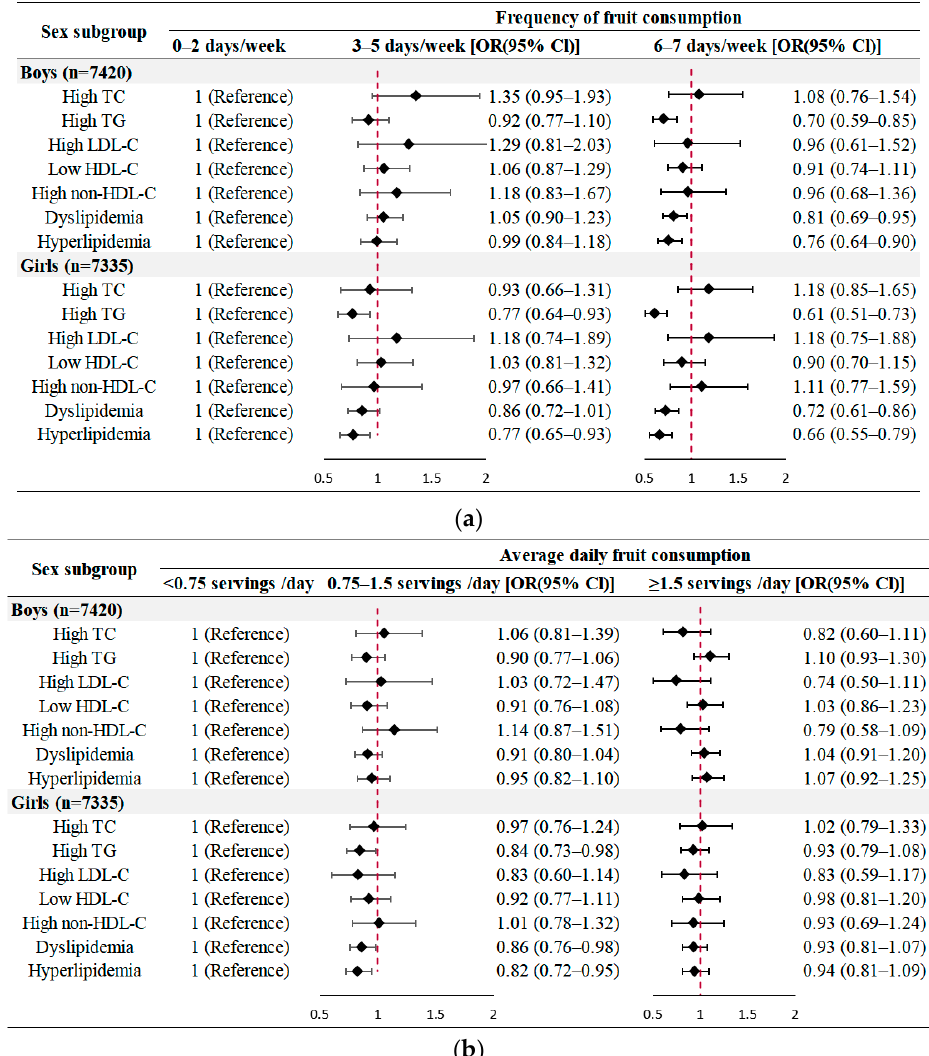
Figure 1. Sex-specific analysis of the associations between fruit consumption and lipid profile (adjusted for age, BMI values, residence area, ethnicity, incomes, parental educational attainment, parental weight, vegetable consumption, sugar-sweetened beverages consumption, meat consump- tion and physical activity) ( a ) Frequency of fruit consumption; ( b ) Average daily fruit consumption. TC, total cholesterol; TG, triglycerides; LDL-C, low density lipoprotein-cholesterol; HDL-C, high density lipoprotein-cholesterol; diamond symbol, point estimates; red dashed line, invalid